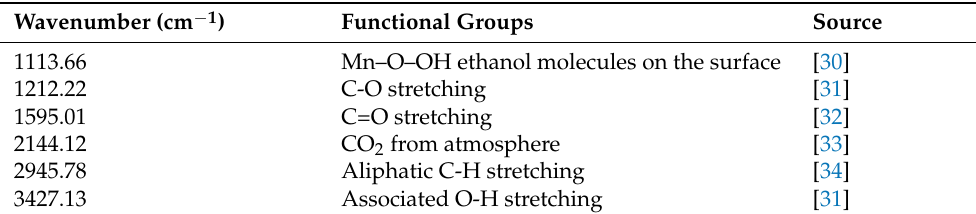
Figure 3. ATR-FTIR spectra of ZnMn 2 O 4 obtained at different times, 6 h (brown), 12 h (red), and 18 h (green). Table 2. Characteristic absorption peaks of FTIR